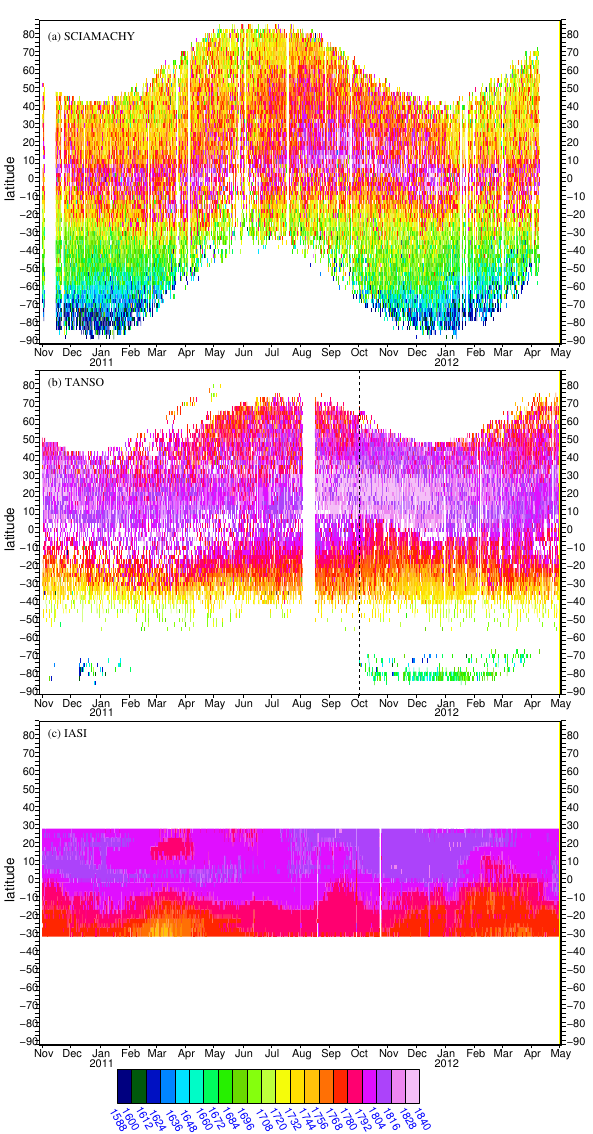
Figure 6. Time series of xCH 4 zonal mean (in ppb) from (a) SCIA- Fig. 6. Time series of x CH zonal mean (in ppb) from SCIAMACHY, TANSO and IASI products (from top to bottom). MACHY, (b) TANSO and (c) IASI products (from top to bottom). 4